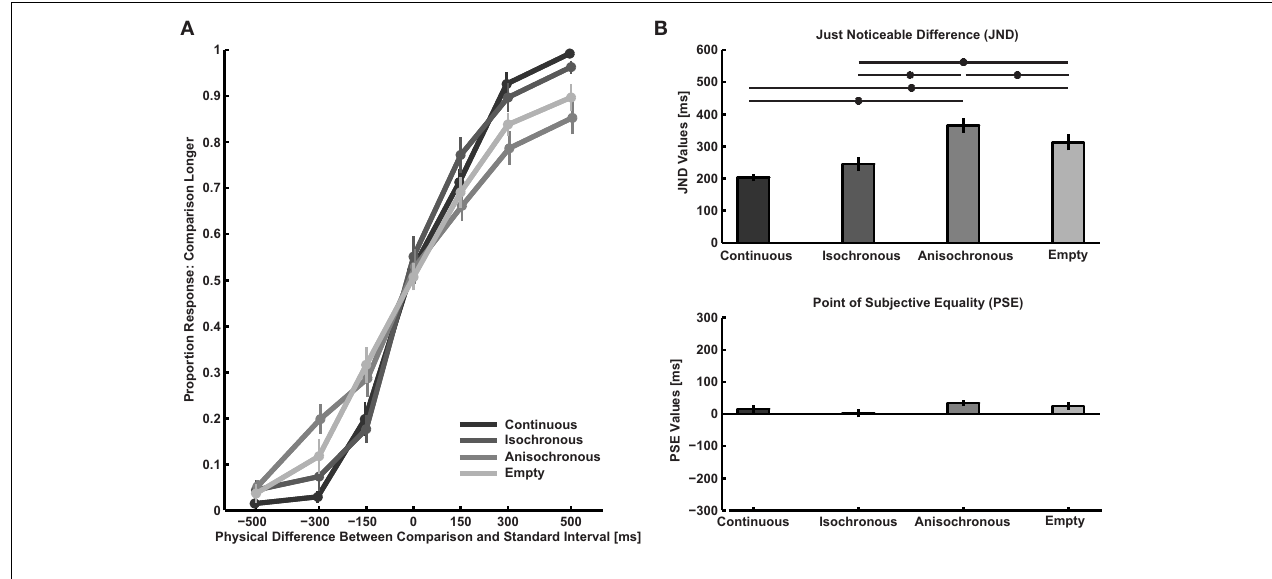
FIGURE 1 | Results of Experiment 1. (A) Participants’ responses recoded to indicate the proportion of responses where the comparison interval was judged longer than the standard interval as a function of physical duration difference. (B) Point of subjective equality (PSE) and just